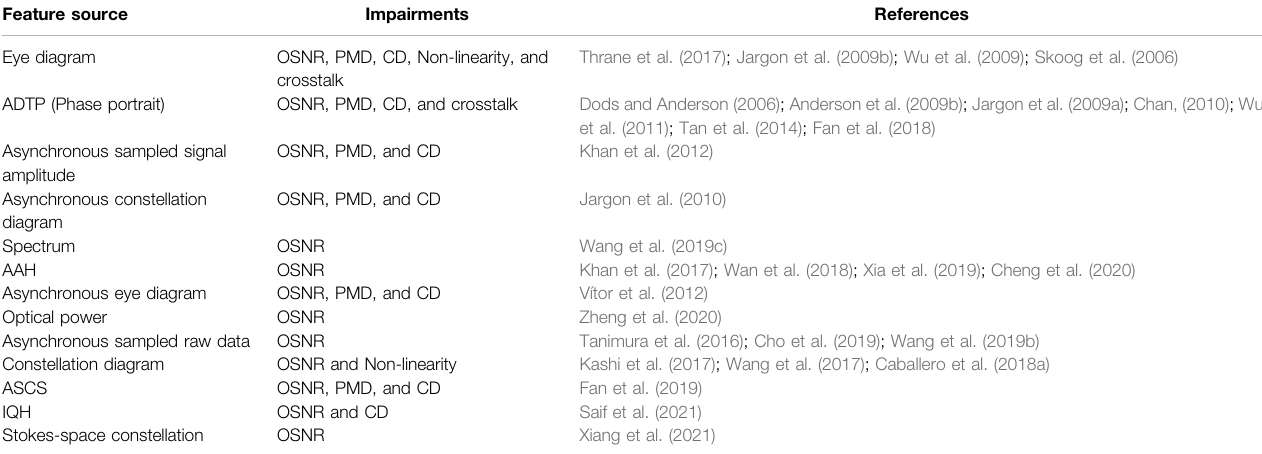
TABLE 1 | Summary of features and monitored impairments used in current